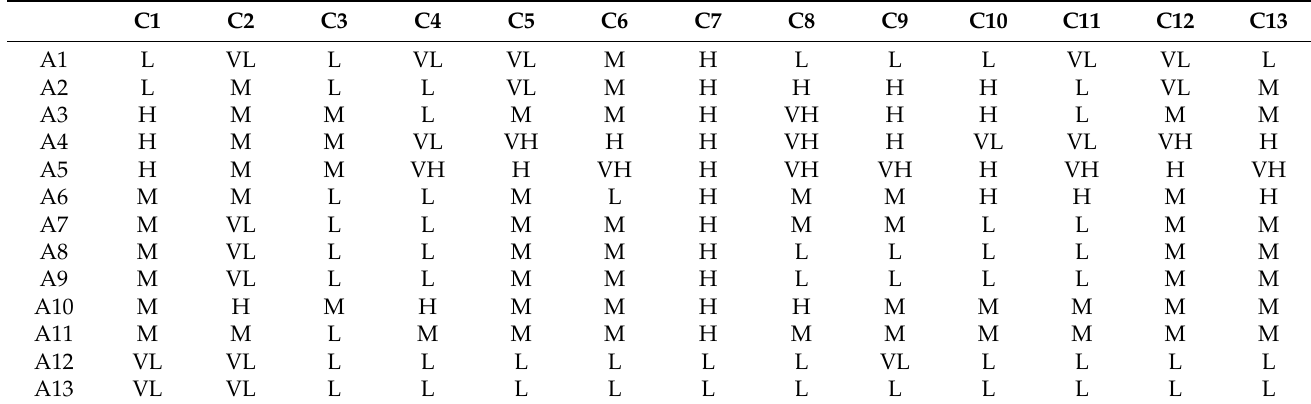
Table A5. Decision maker 3 (cid:48) s linguistic assessment.